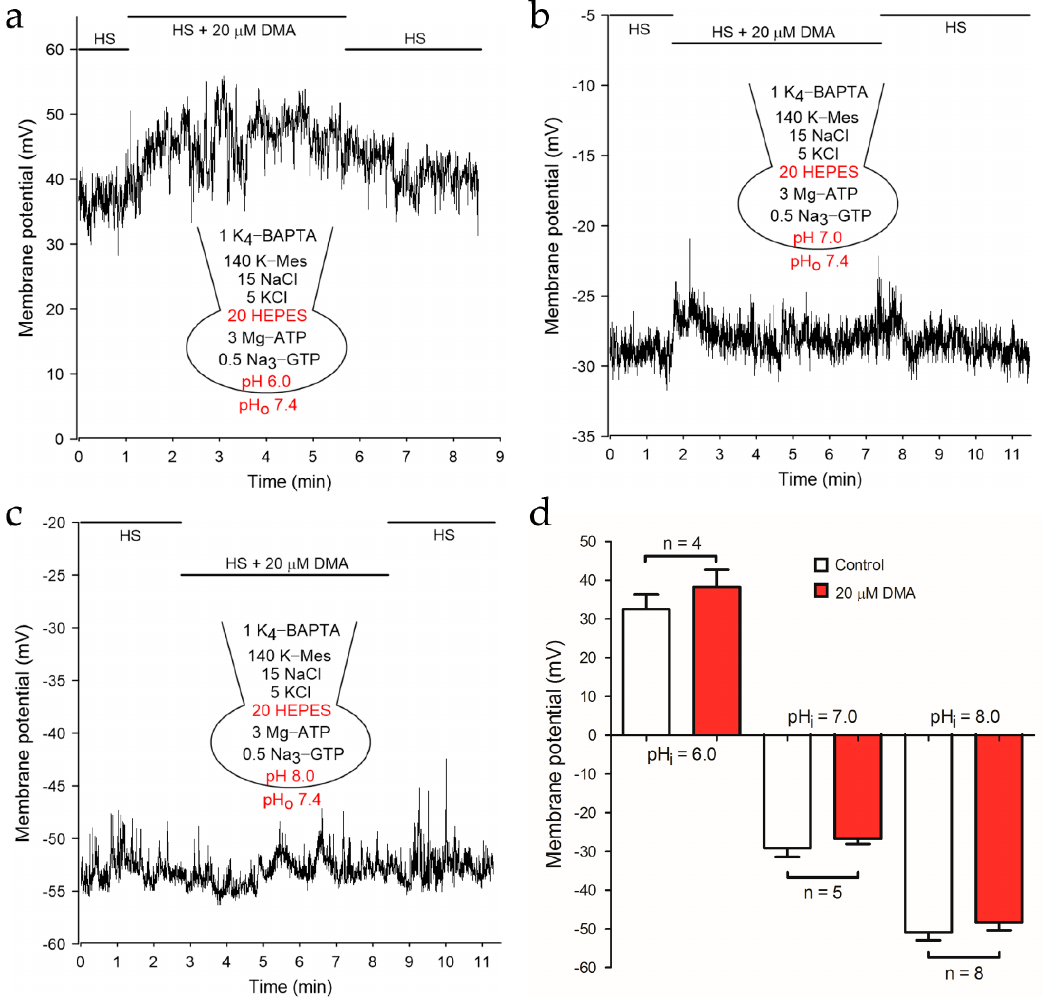
Figure 2. DMA failed to depolarize the membrane potential in a pH buffered pipette solution. Representative traces of membrane potentials recorded by the current clamp at pH i 6.0 ( a ), pH i 7.0 ( b ), pH i 8.0 ( c ) was shown in the absence or presence of 20 μ M DMA. HS solution containing 135 mM Na + was employed to maintain NHEs activity. ( d ) Mean amplitudes of membrane potential before and after the treatment of DMA at pH i 6.0 ( n = 4), pH i 7.0 ( n = 5) and pH i 8.0 ( n = 8). Data are expressed as mean ± SEM.